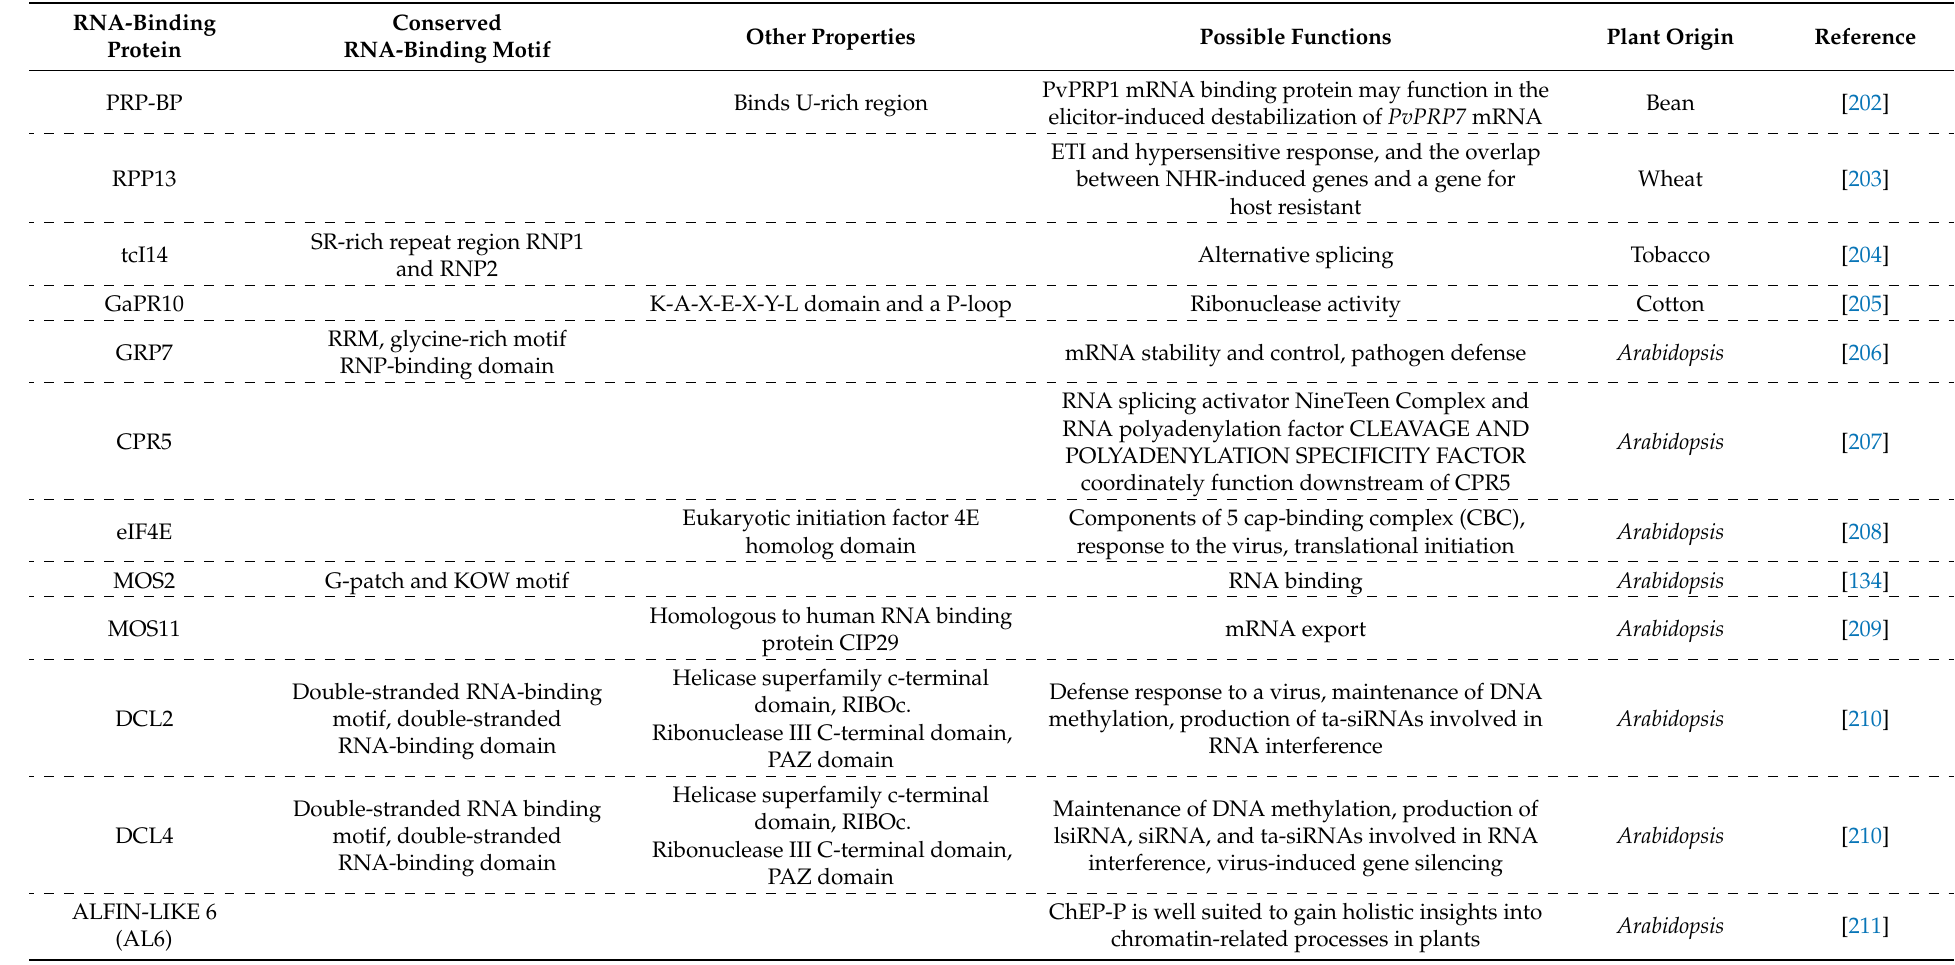
Table 2. Several RBPs are involved in plant